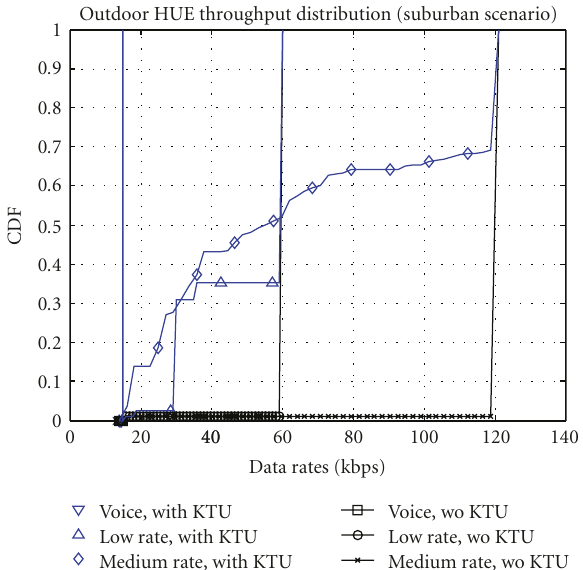
Figure 5: Distribution of indoor HUE throughput in the presence of Kitchen Table MUEs.